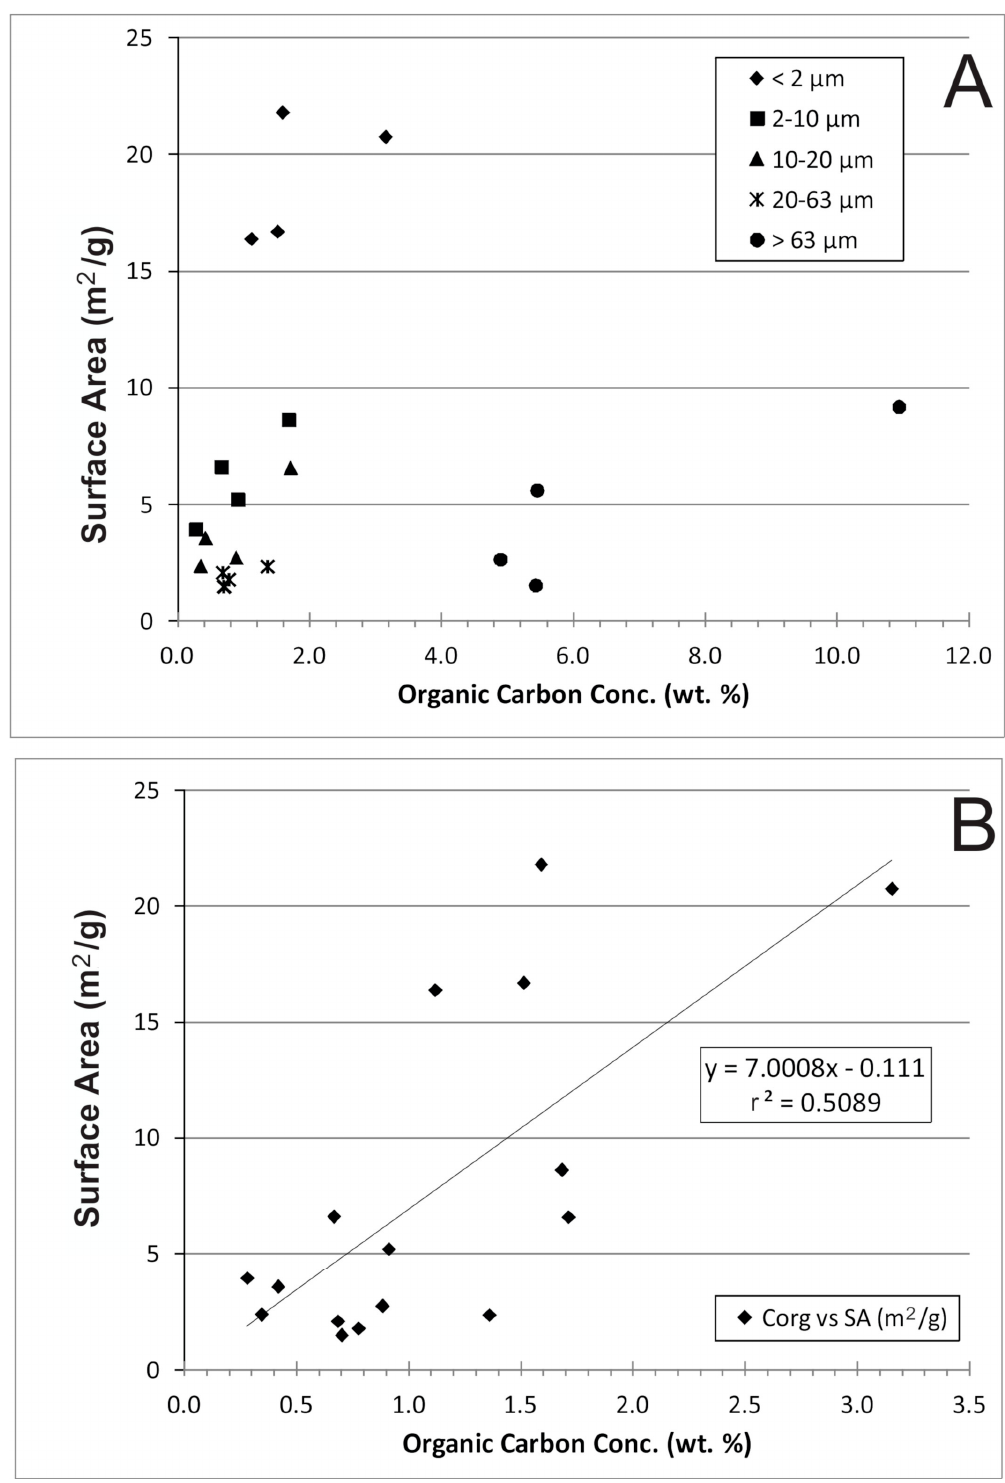
Figure 12. ( A ) Plot of surface area versus organic carbon (C org ) for size fractionated samples. The > 63 µ m fraction plots to the right of the graph due to its high C org content and low surface area. ( B ) Plot of surface area and C org for size fractionated samples with the > 63 µ m fraction removed. The plot has a moderate positive correlation, r 2 =